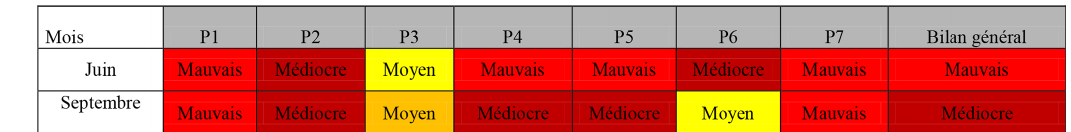
Tableau B5. Evaluation du risque d’eutrophisation de la retenue d’eau (Ifremer, 2000).